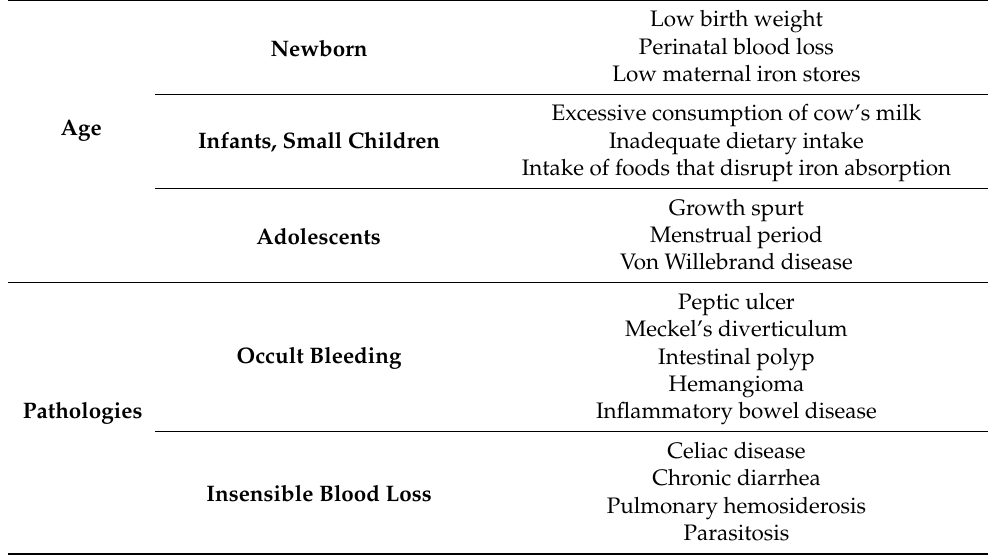
Table 1. Causes of iron deficiency anemia according to age and different pathologies [8]. Low birth weight Perinatal blood loss Newborn Low maternal iron stores Excessive consumption of cow’s milk Age Inadequate dietary intake Infants, Small Children Intake of foods that disrupt iron absorption Growth Adolescents